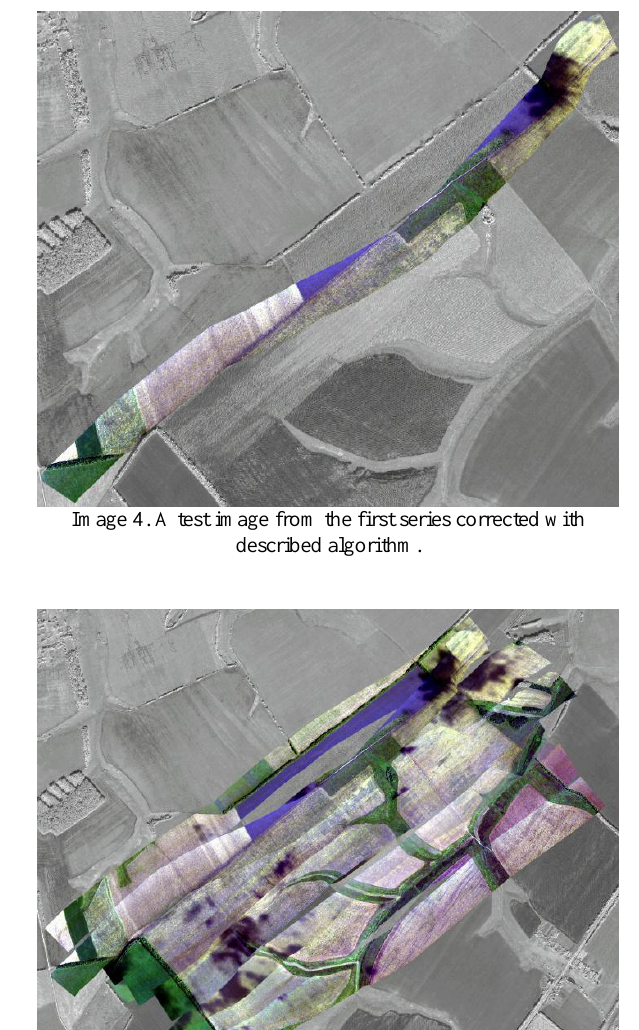
ALGORITHM TESTING METHOD